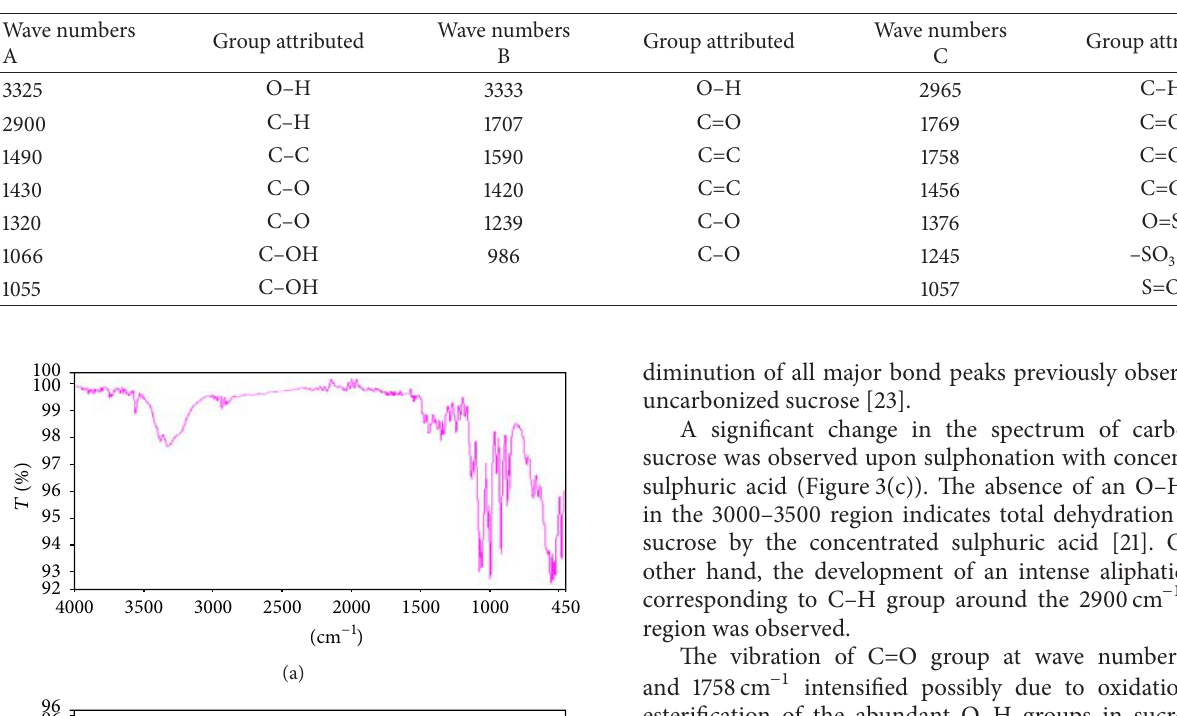
Table 1: FTIR spectra represented as wave numbers for untreated sucrose (A), carbonized sucrose (B), and carbonized + sulphonated sucrose (C).